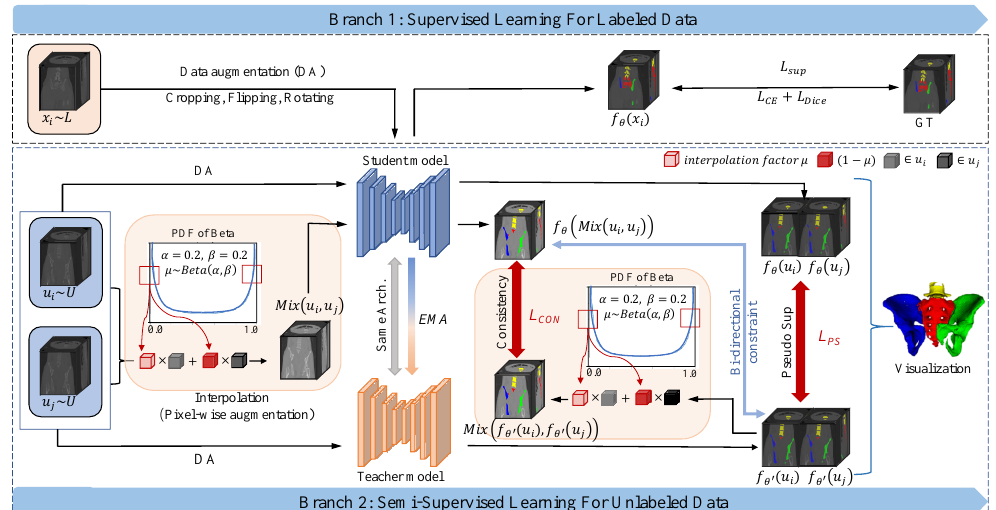
Figure 2. Schematic view of the proposed bi-directional constrained dual-task consistency method on CTPelvic1k dataset. The framework consists of two branches: supervised learning and semi-supervised learning. The below semi-supervised part is the combination of interpolation consistency regularization task and pseudo-label supervision task. The backbone models share the same architecture, and the weight of teacher model is the exponential moving average (EMA) of the student model. The “PDF” in the interpolation part represents the probability density function of beta distribution, “α” and “β” are the parameter of beta distribution, “μ” is the interpolation factor.